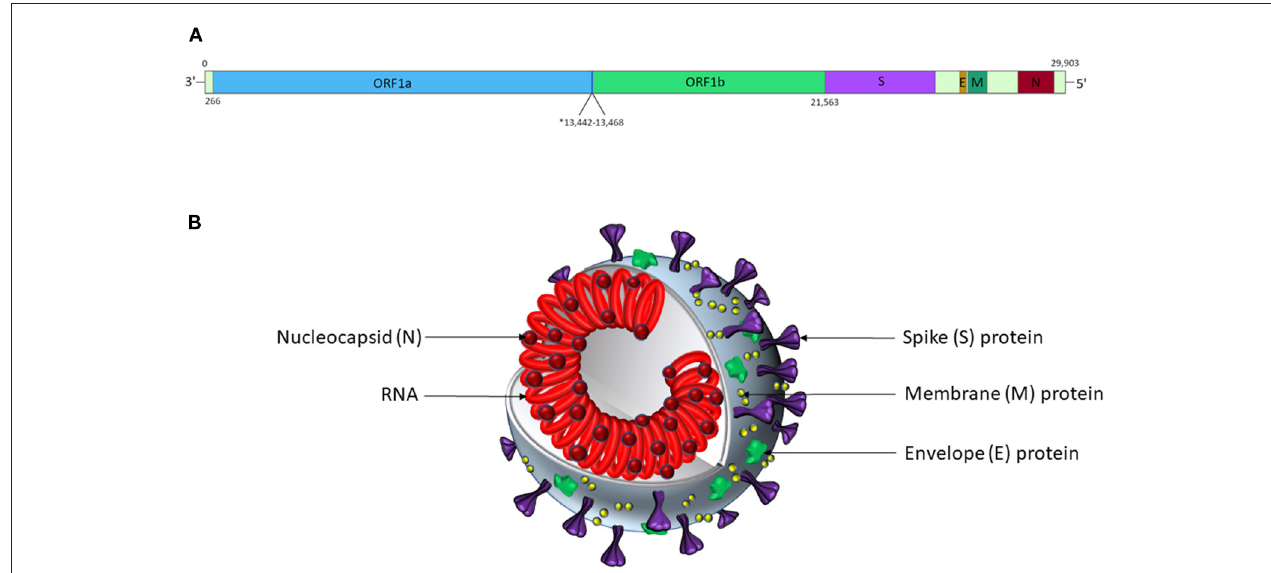
FIGURE 1 | SARS-CoV-2 genomic and virion structures. (A) Genome schematic of SARS-CoV-2. The asterisk marks the overlapping reading frames of ORF1a and ORF1b, which encode a variety of non-structural proteins, including helicases, proteases, and an RNA-dependent RNA polymerase. The S protein is encoded by nt. 21,563-25,384; the E protein is encoded by nt. 26,245-26472; the M protein is encoded by nt. 26,523-27,191; and the N protein is encoded by nt. 28,274-29,533. Accessory proteins not shown. Adapted from Alanagreh et al. ( 91). (B) Schematic representation of the SARS-CoV-2 virion structure. This figure is not to scale, and relative abundances of the proteins shown are arbitrary.